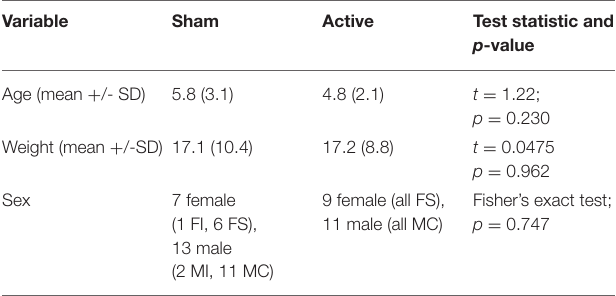
TABLE 2 | Demographics of participating